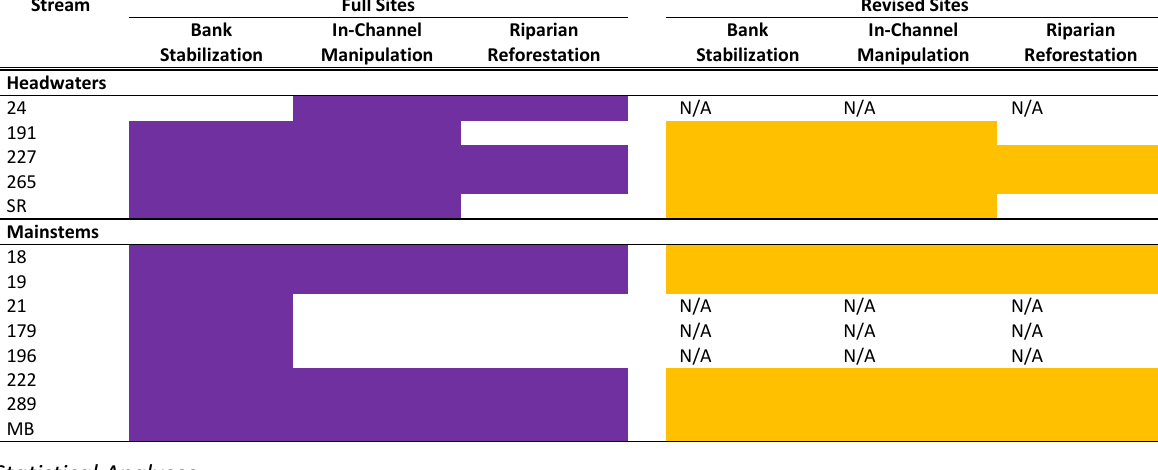
Table 1 : Schematic of restoration treatments applied to each stream. Shaded cells represent the restoration treatments that were applied to each stream, with full sites in purple and revised sites in yellow. Sites excluded in the revised sites analysis are denoted with N/A. Stream Full Sites Revised Sites Bank In-Channel Riparian Bank In-Channel Riparian Stabilization Manipulation Reforestation Stabilization Manipulation